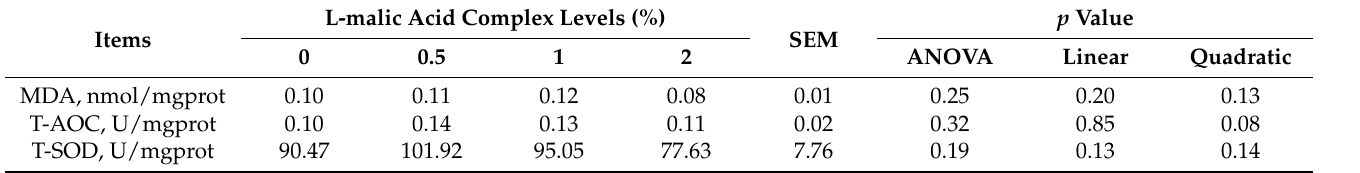
Table 8. Effects of dietary supplementation with L-malic acid on the antioxidant capacity of the LD muscle in finishing pigs ( n =